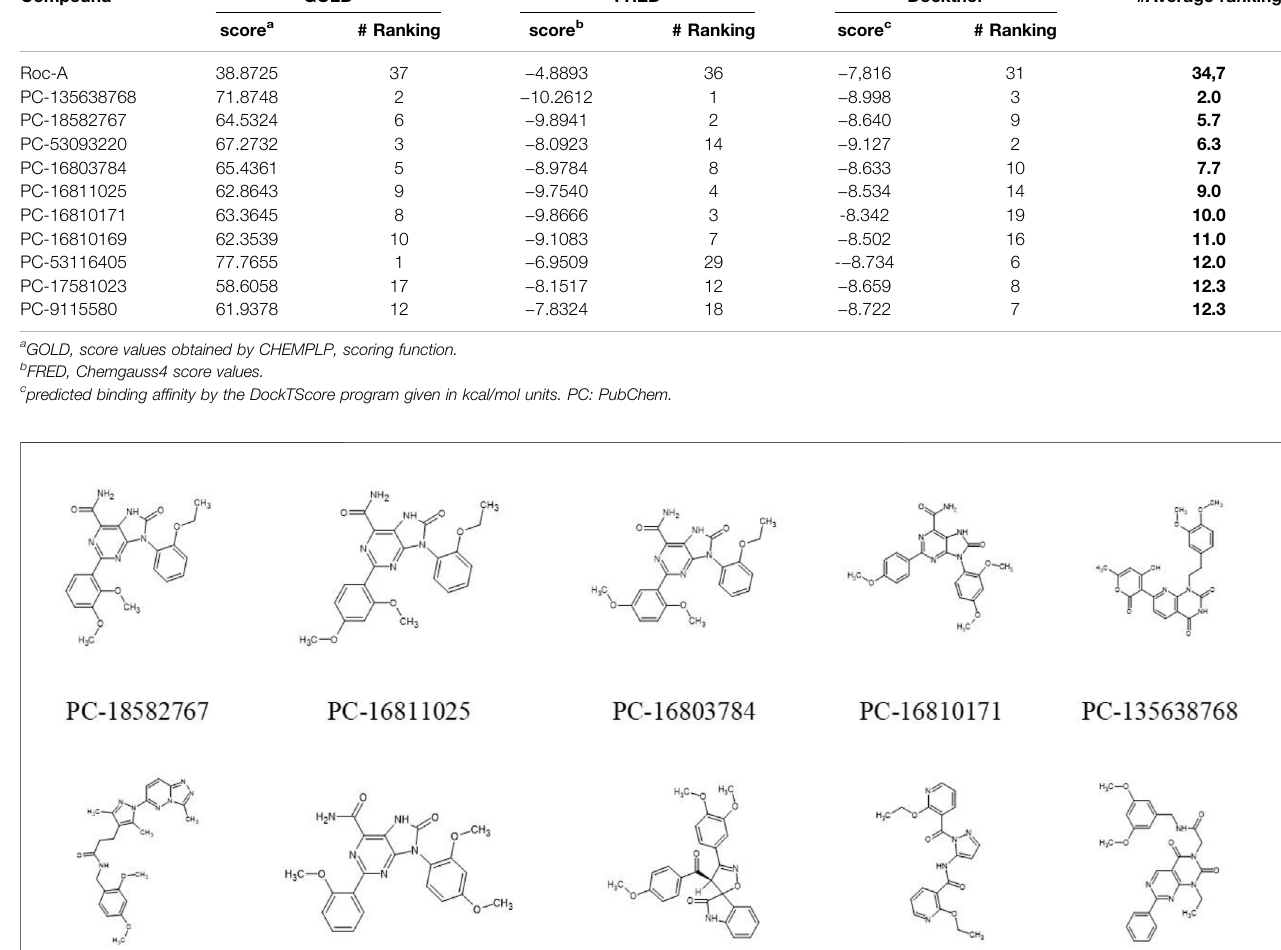
TABLE 10| Top 10compoundsselectedaccording totheirbest averagerankingvalues, whichinturnwerecalculatedfromeach individualrankingandcorrespondingscores obtained using 3 docking software (GOLD, FRED and Dockthor).